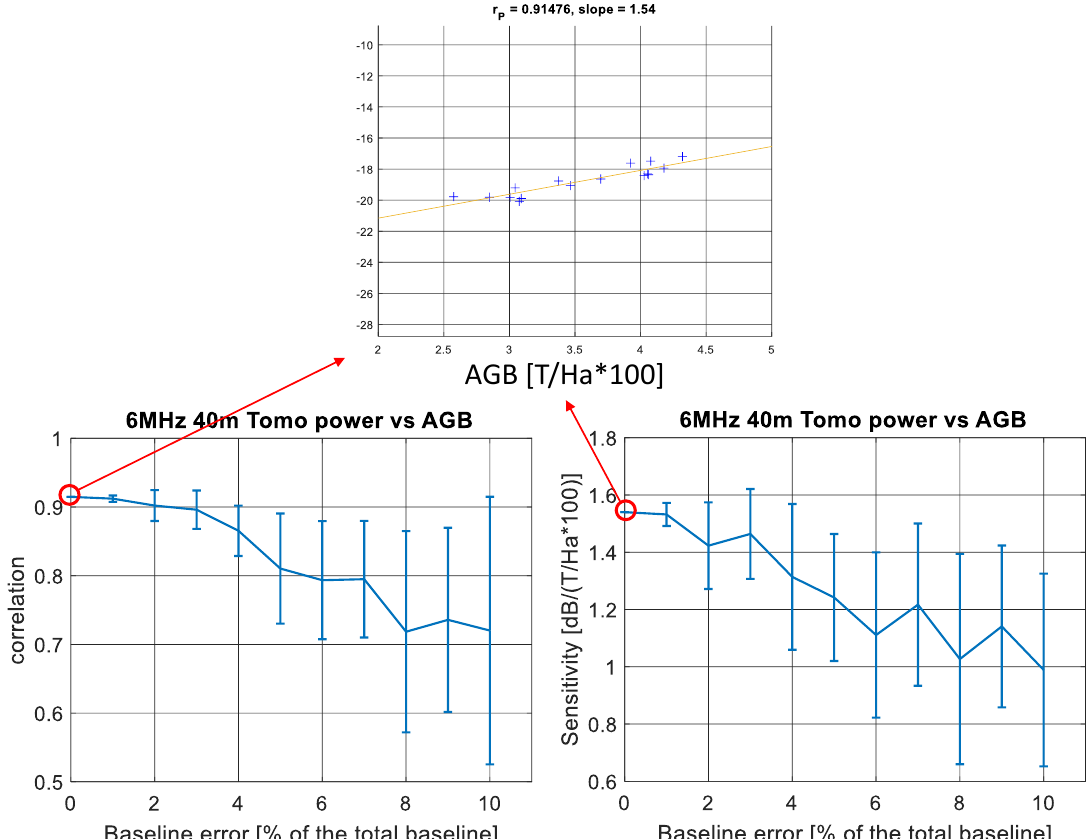
Figure 12. Evolution of the sensitivity and correlation to the above ground biomass (AGB) of the tomographic power at 40 m above the ground level as the sampling of the baseline aperture drives away from the regular grid. The top panel shows the scatterplot relating tomographic power and AGB in case of perfectly regular